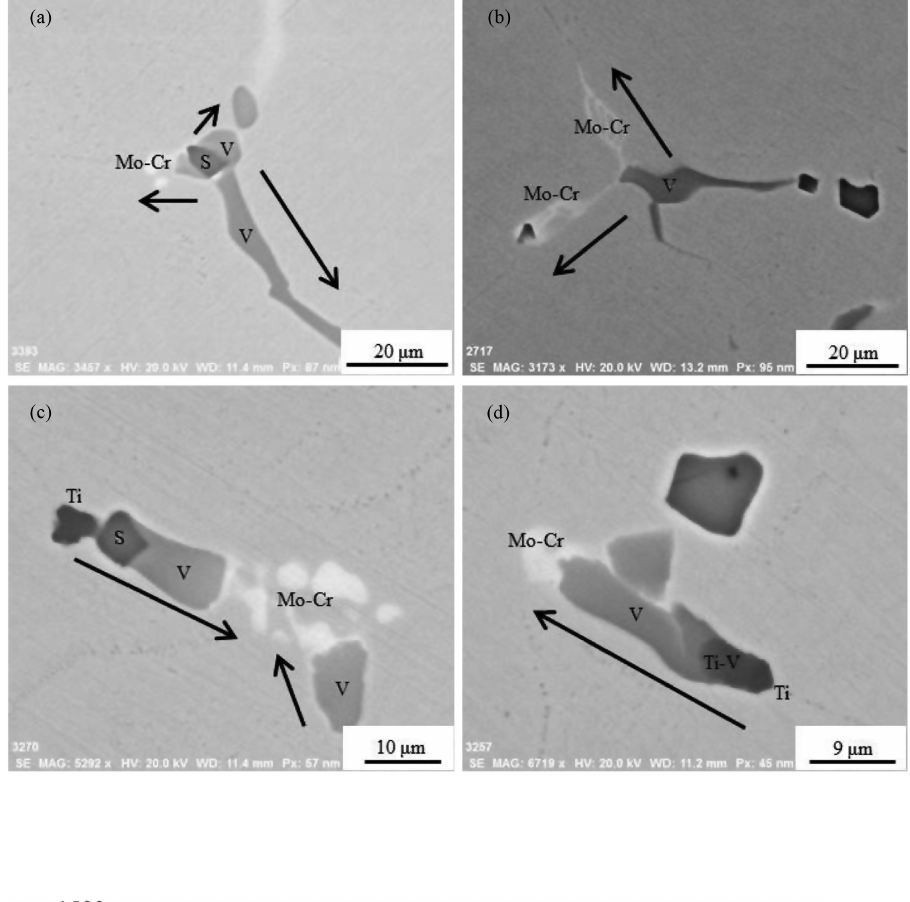
Figure 4: Large precipitates connecting with each other.